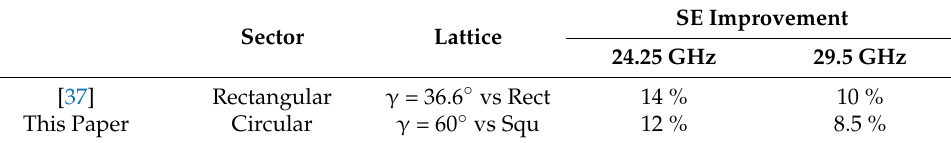
Table 4. Percentage SE improvement offered by the most suitable triangular lattice, compared to rectangular/square lattices, in the case of planar arrays composed of 64 elements (8 × 8) for 20 served users inside the different sector